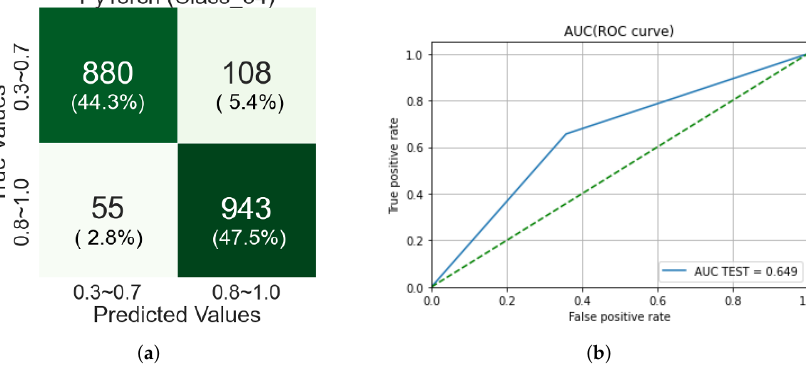
Figure 19. Validation results of EfficientNet-B7-based CNN classification for Step-2-2. ( a ) Confusion matrix; ( b ) AUC (ROC)